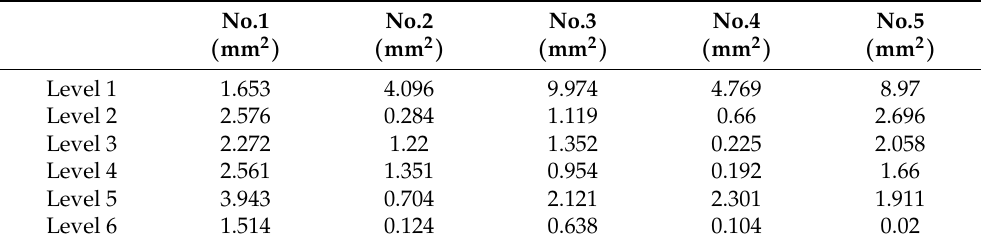
Table 3. Discrepancies between model predictions and experimental